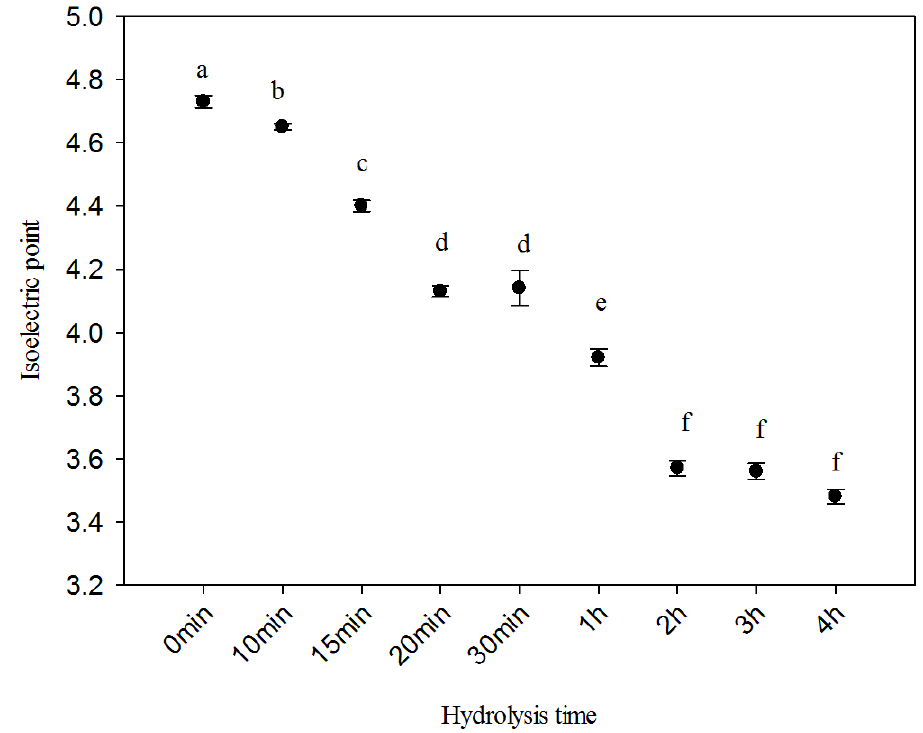
1 standard deviation) serum 25-hydroxyvitamin D concentration Figure 1. Mean (error bars Figure 3. Isoelectric point of ovine collagen hydrolysates as a function of hydrolysis time. Di ff erent ± by season of blood collection in adults aged 18 years who were born in Africa and were letters indicate significant di ff erence at p 0.05. ≥ ≤ included in the current study (North Africa and Middle East, n = 95; Sub-Saharan Africa, n = 141) in summer (December–February), autumn (March–May), winter (June–August) and spring (September–November).